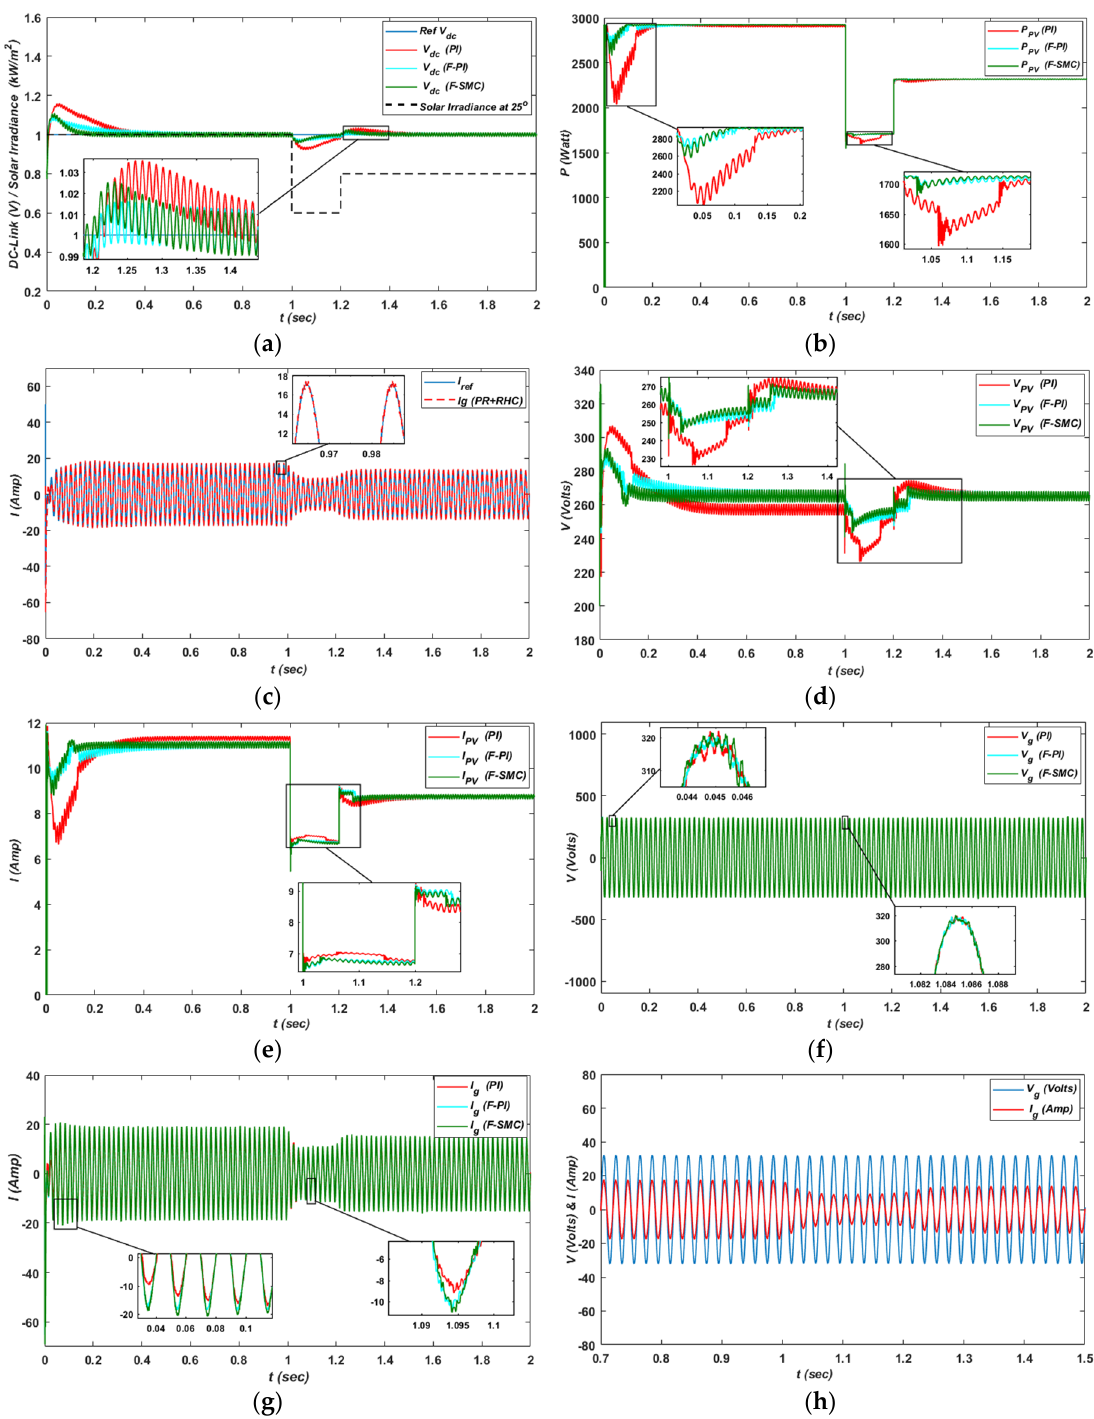
Figure 9. ( a ) DC-link voltage and SI using PI, F-PI, and F-SMC; ( b ). PV panels power using PI, F-PI, and F-SMC; ( c ) proportional resonant controller with RHC for the current loop; ( d ) PV panels voltages using PI, F-PI, and F-SMC; ( e ) PV panels currents using PI, F-PI, and F-SMC; ( f ) grid voltages using PI, F-PI, and F-SMC; ( g ) grid currents using PI, F-PI, and F-SMC; ( h ) response of the grid voltage and grid